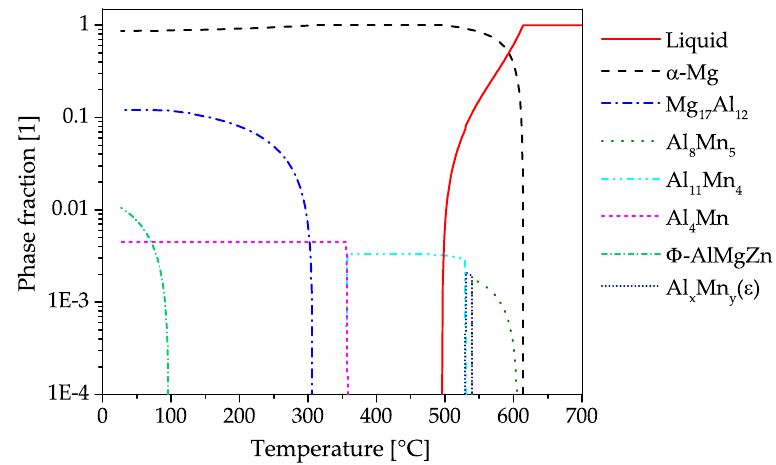
Figure 11. CALPHAD calculations (for further information see Appendix A) of AZ61 in a temperature range of 25 to 700 ◦ C, showing phase fractions of 10 − 4 to